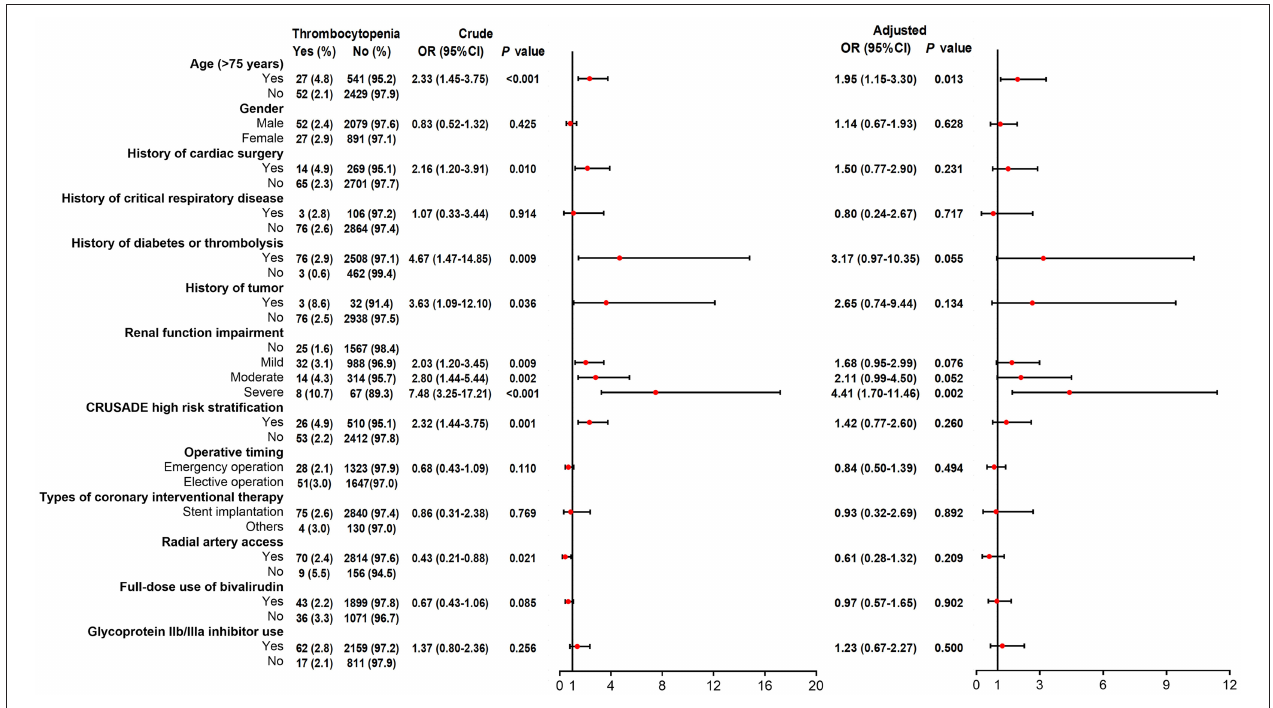
FIGURE 3 | Logistic regression analyses for factors of bivalirudin related thrombocytopenia